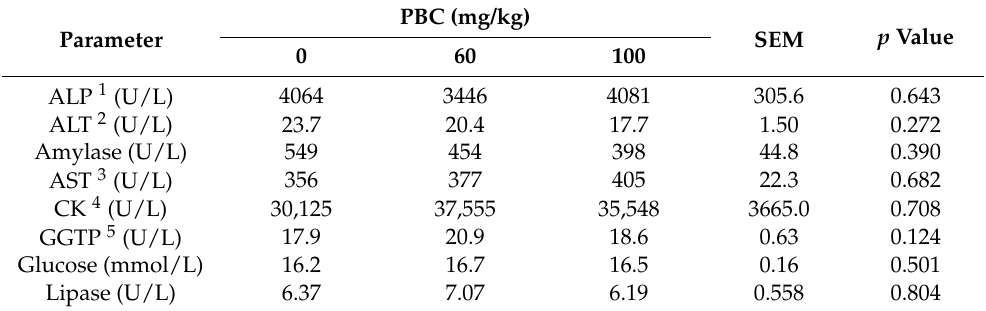
Table 3. Biochemical blood indices in chickens fed diets supplemented with 60 and 100 mg/kg PBC.